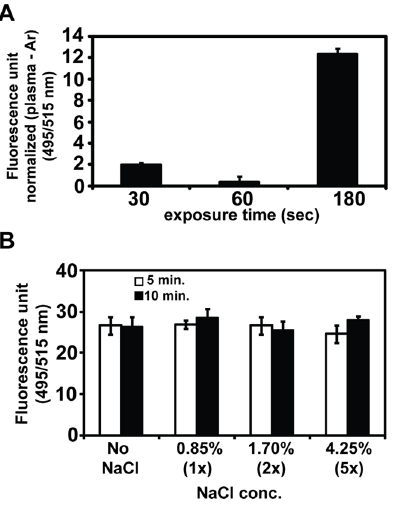
Figure 7. Intracellular level of NO during plasma exposure time and in different concentrations of NaCl. ( A ) Intracellular NO level was measured after plasma exposure in saline for 30, 60, and 180 sec. Fluorescence values are normalized, in which the level measured after Ar gas treatment was subtracted from that measured after plasma treatment. ( B ) NO level was measured in cells incubated in different concentrations of NaCl solution for 5 and 10 min. Each value is the average of three technical